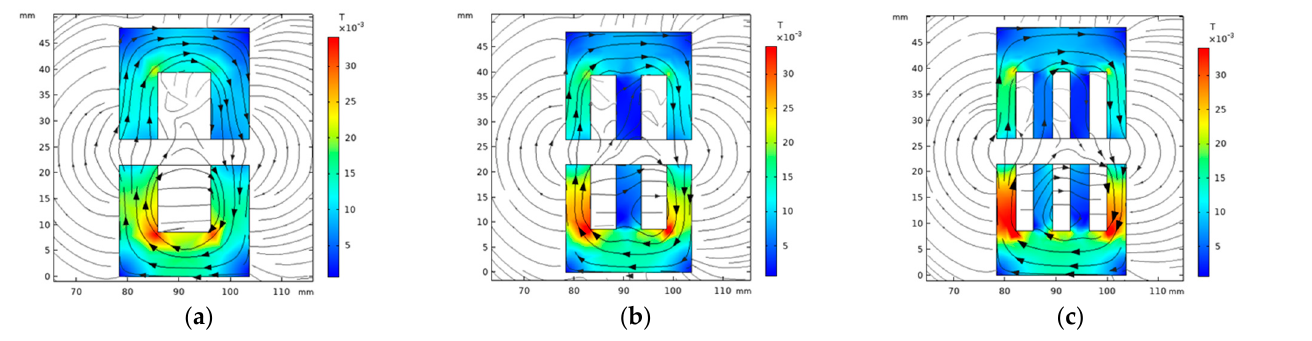
Figure 2. Magnetic flux density of different magnetic coupling structures. ( a ) U-shaped; ( b ) E- shaped; ( c ) UE-shaped.